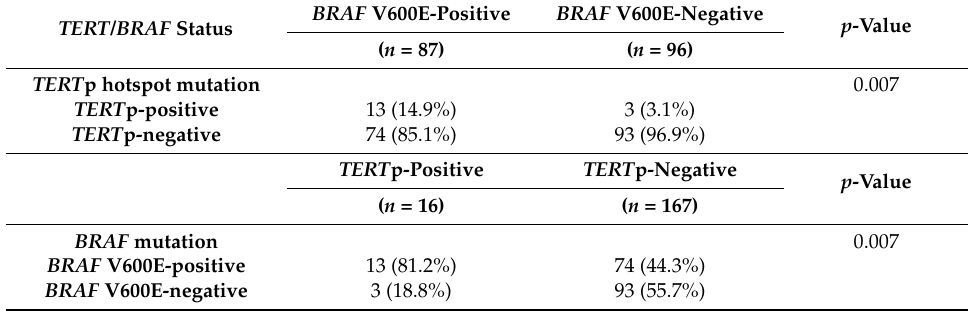
Table 1. Association of TERT promoter ( TERT p) hotspot mutations and the BRAF V600E